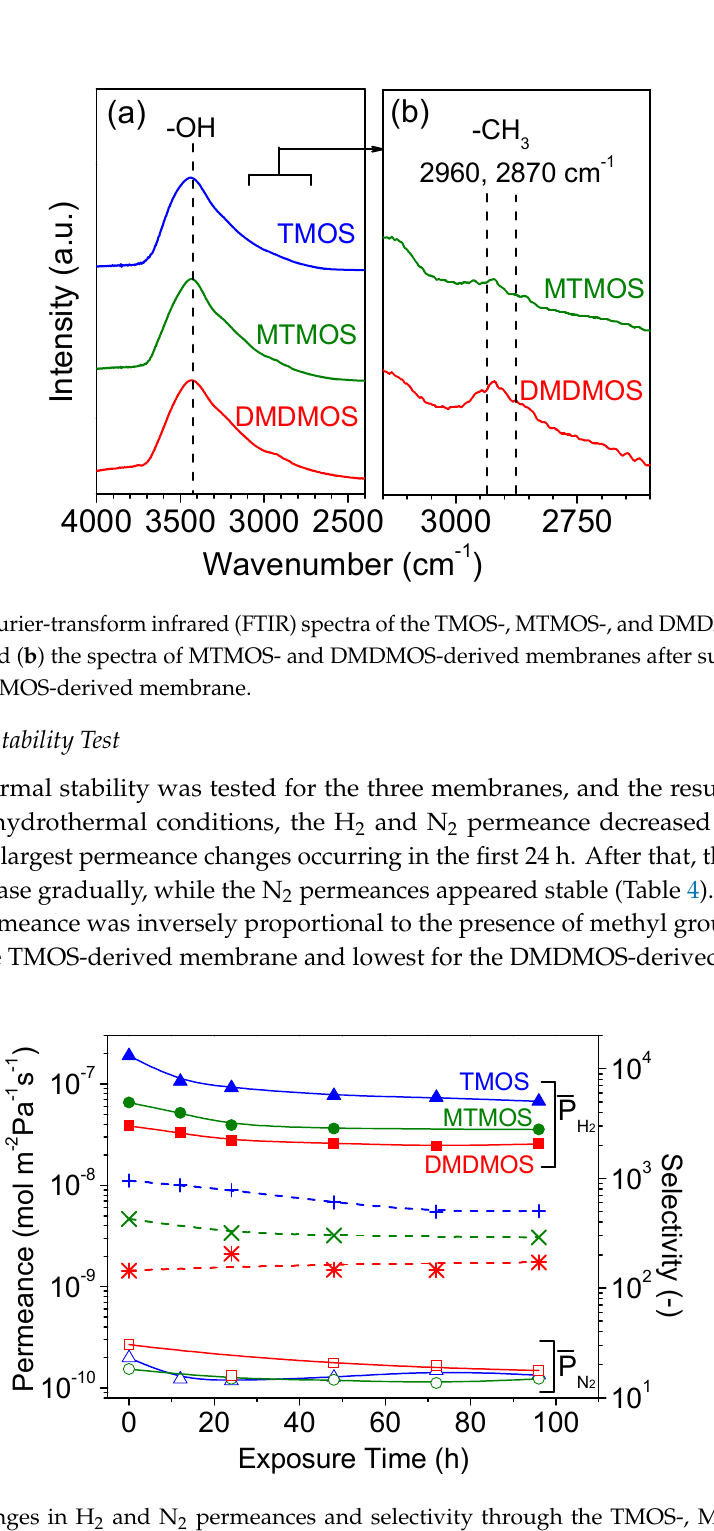
Figure 9. Changes in H 2 and N 2 permeances and selectivity through the TMOS-, MTMOS-, and DMDMOS-derived membranes under 15 mol.% H 2 O at 650 °C.